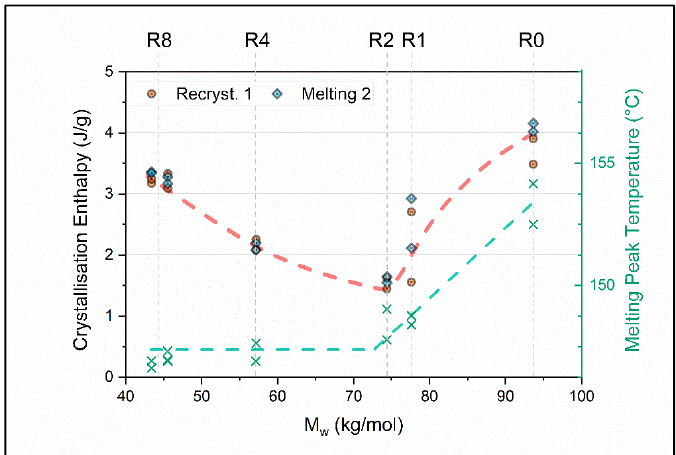
Figure 6. Left axis: Enthalpy of crystallization as a function of weight average molar mass M w . Right axis: Corresponding melting peak temperature in dependence of the average molar mass. The top axis indicates the recycling step Rx (x = 0, 1, 2, 4, and 8). The dashed lines are a guide to the eye.